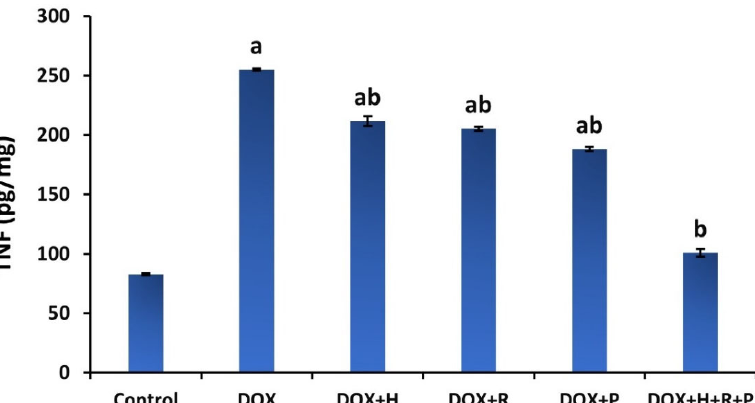
Figure 3. Effect of honey, royal jelly, and propolis on TNF- α of rats treated with Doxorubicin. Values are shown as mean ± SE. Statistically. Different lowercase letters indicate significant differences compared to the corresponding value in the control group at p < 0.05.